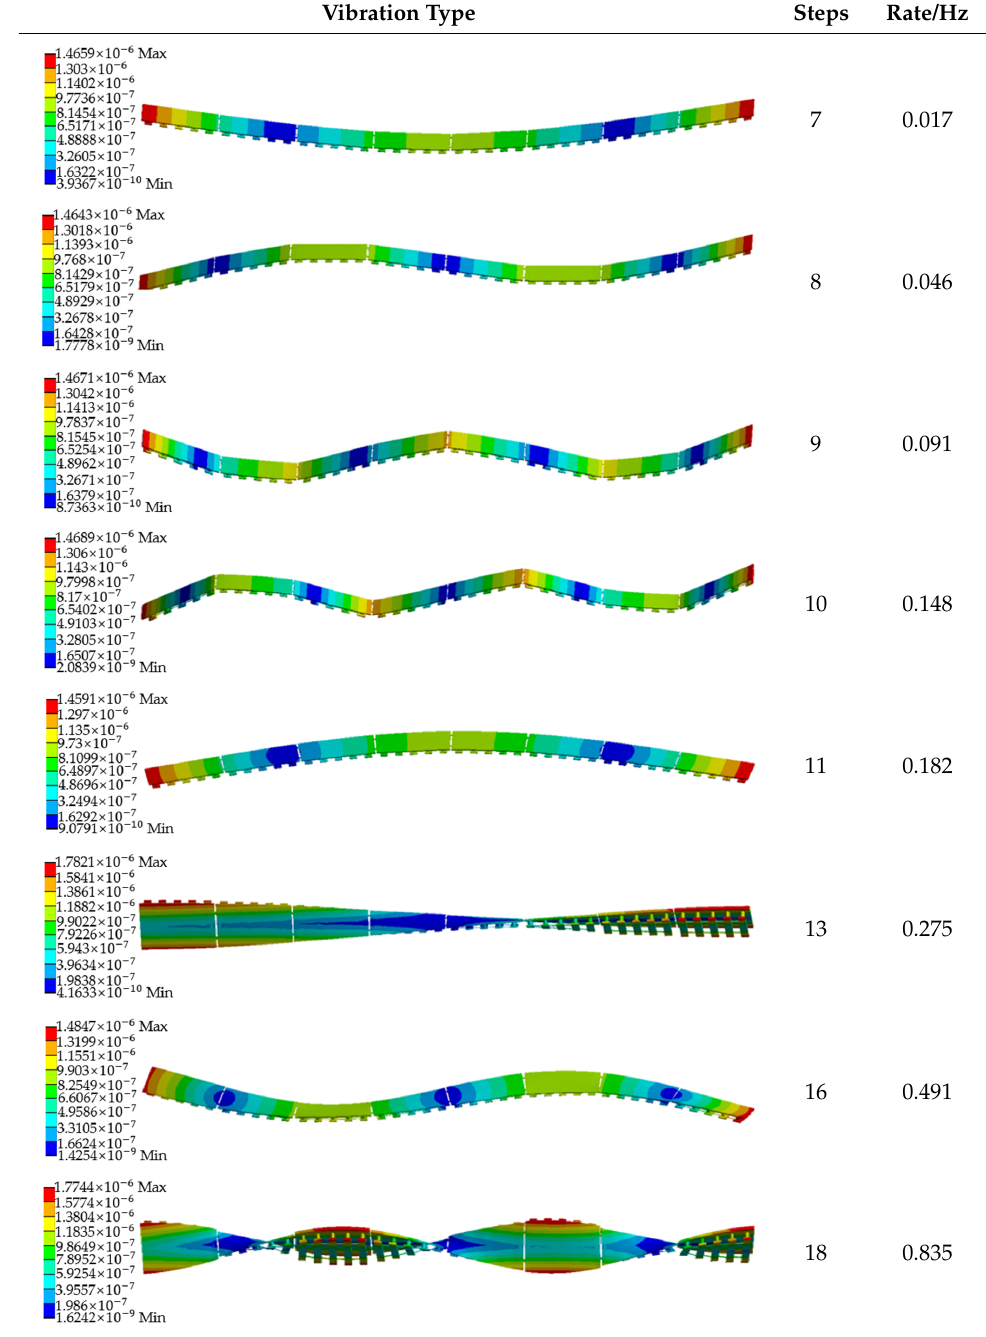
Table 4. Frequency and typical mode of maritime airport.